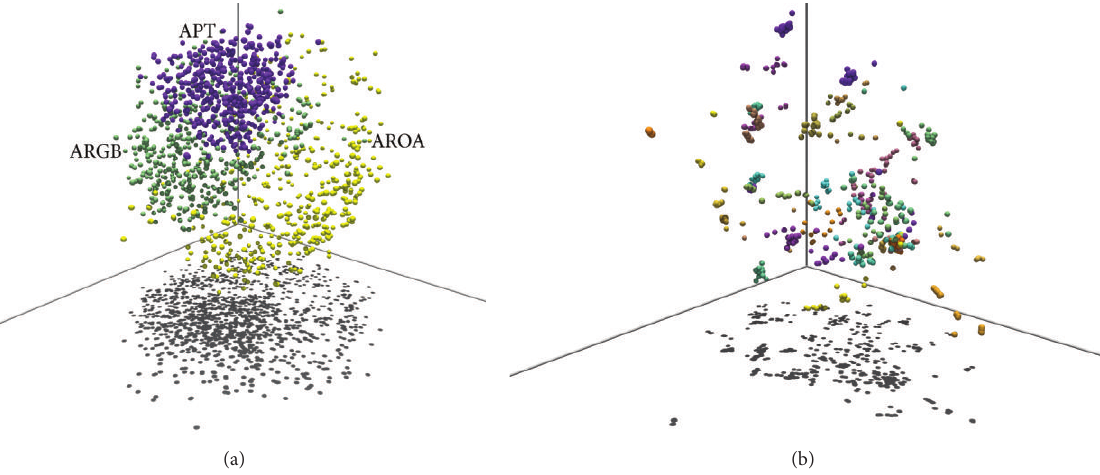
Figure 13: (a) Locus (𝑎,𝑏, 𝑐) of genes APT, ARGB, and AROA (1803 2-tuple HRFs) in Dataset 1—HRF Jensen-Shannon correlation and MDS 3D clustering. (b) Locus (𝑎,𝑏, 𝑐) of 36 genes (782 2-tuple HRFs) in Dataset 2—HRF Jensen-Shannon correlation and MDS 3D